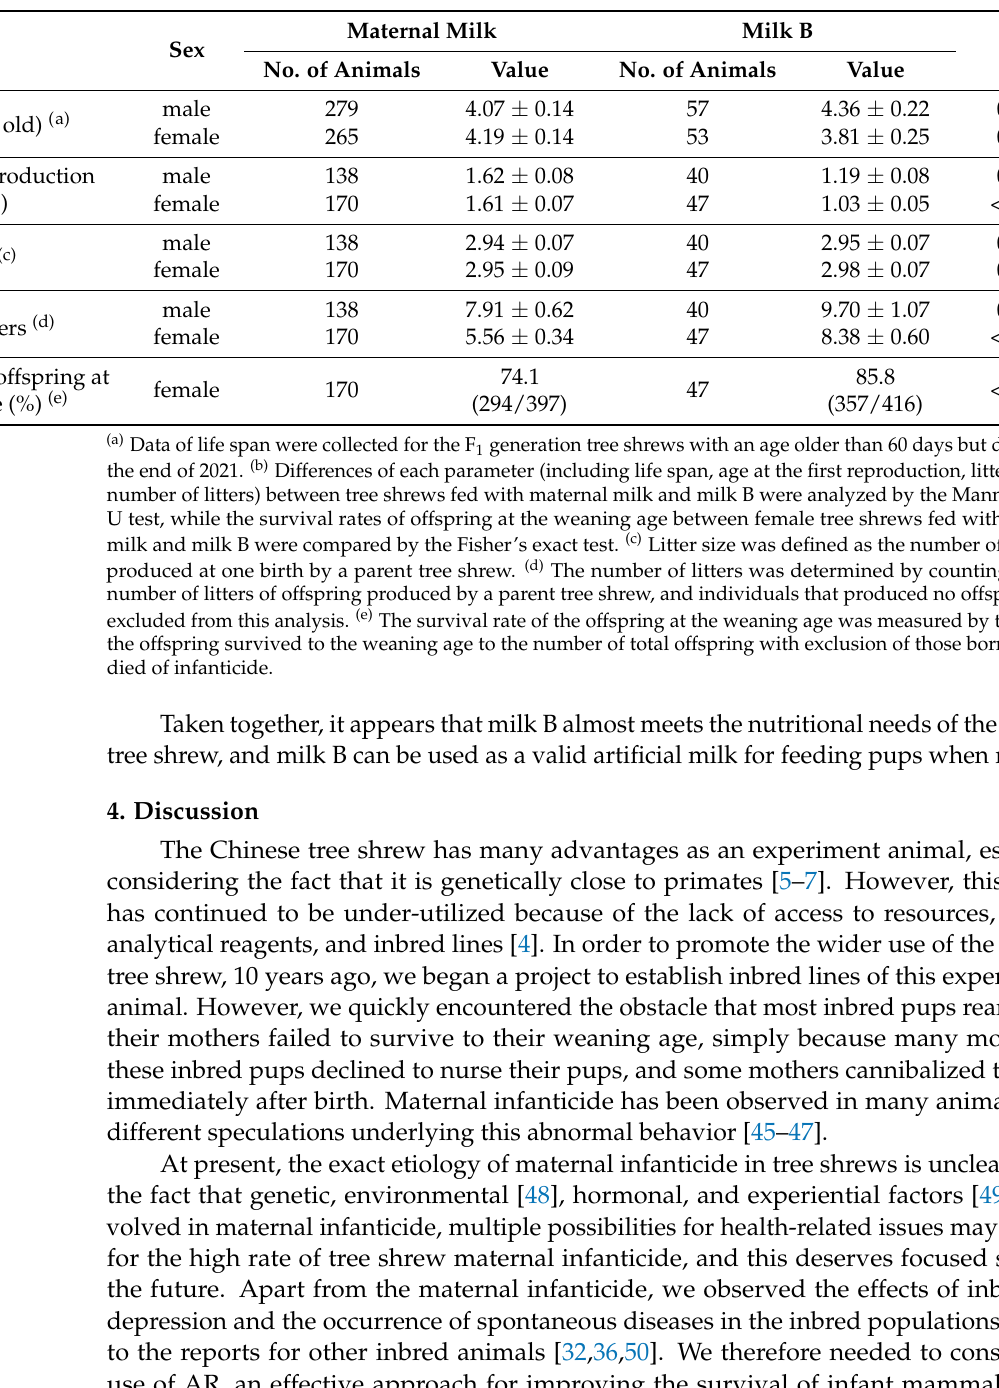
Table 4. Comparison of the life span and reproductive performance of the F 1 generation tree shrews fed with maternal milk and milk B in the inbreeding colonies during